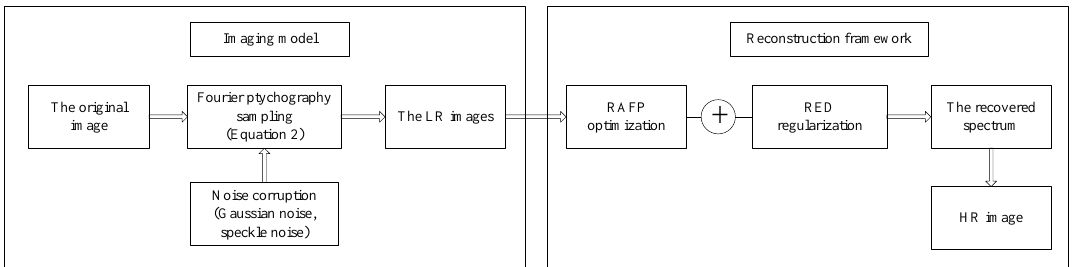
Algorithm 1 The imaging reconstruction framework